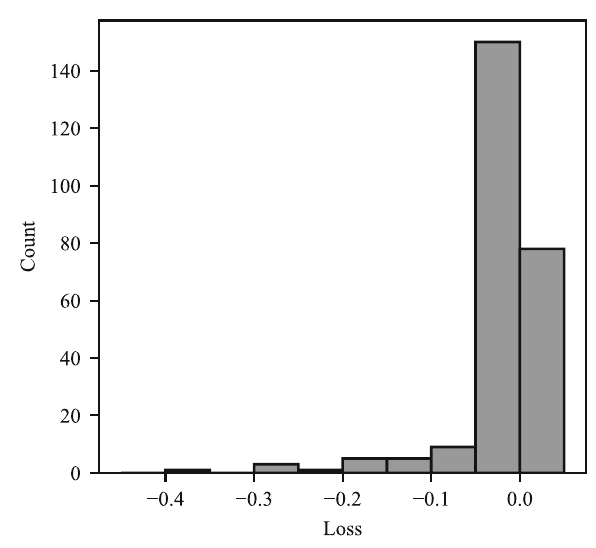
Fig. 7 Histogram of null hypothesis losses, J FlyNet − J